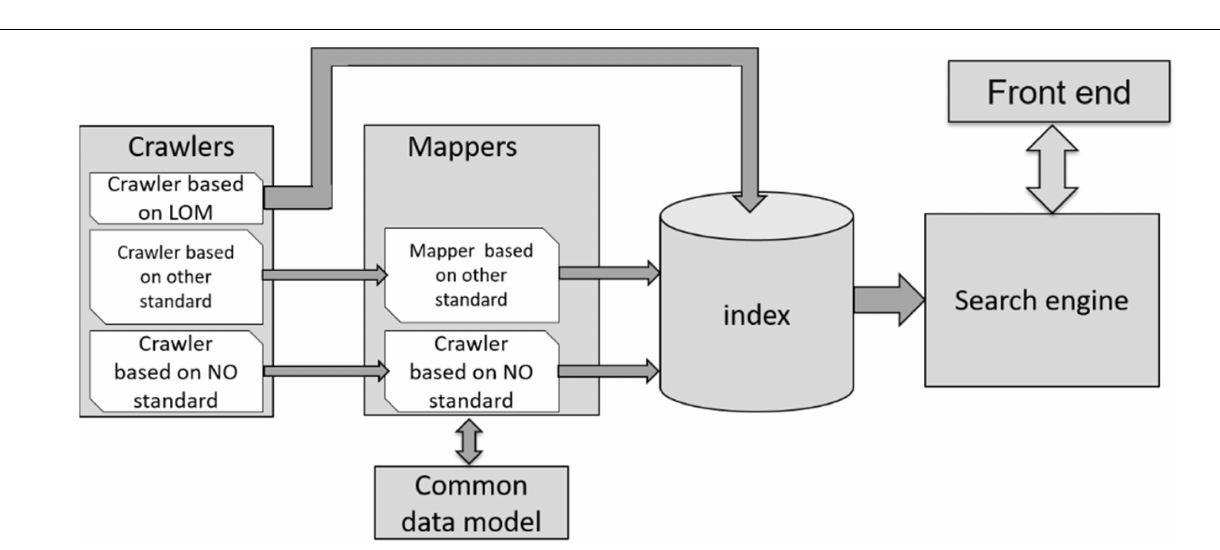
FIGURE 4 | A scenario of harvesting and mapping the open educational resources (OER) metadata that are modelled using the learning object metadata (LOM) standard (Abdel-Qader et al.,